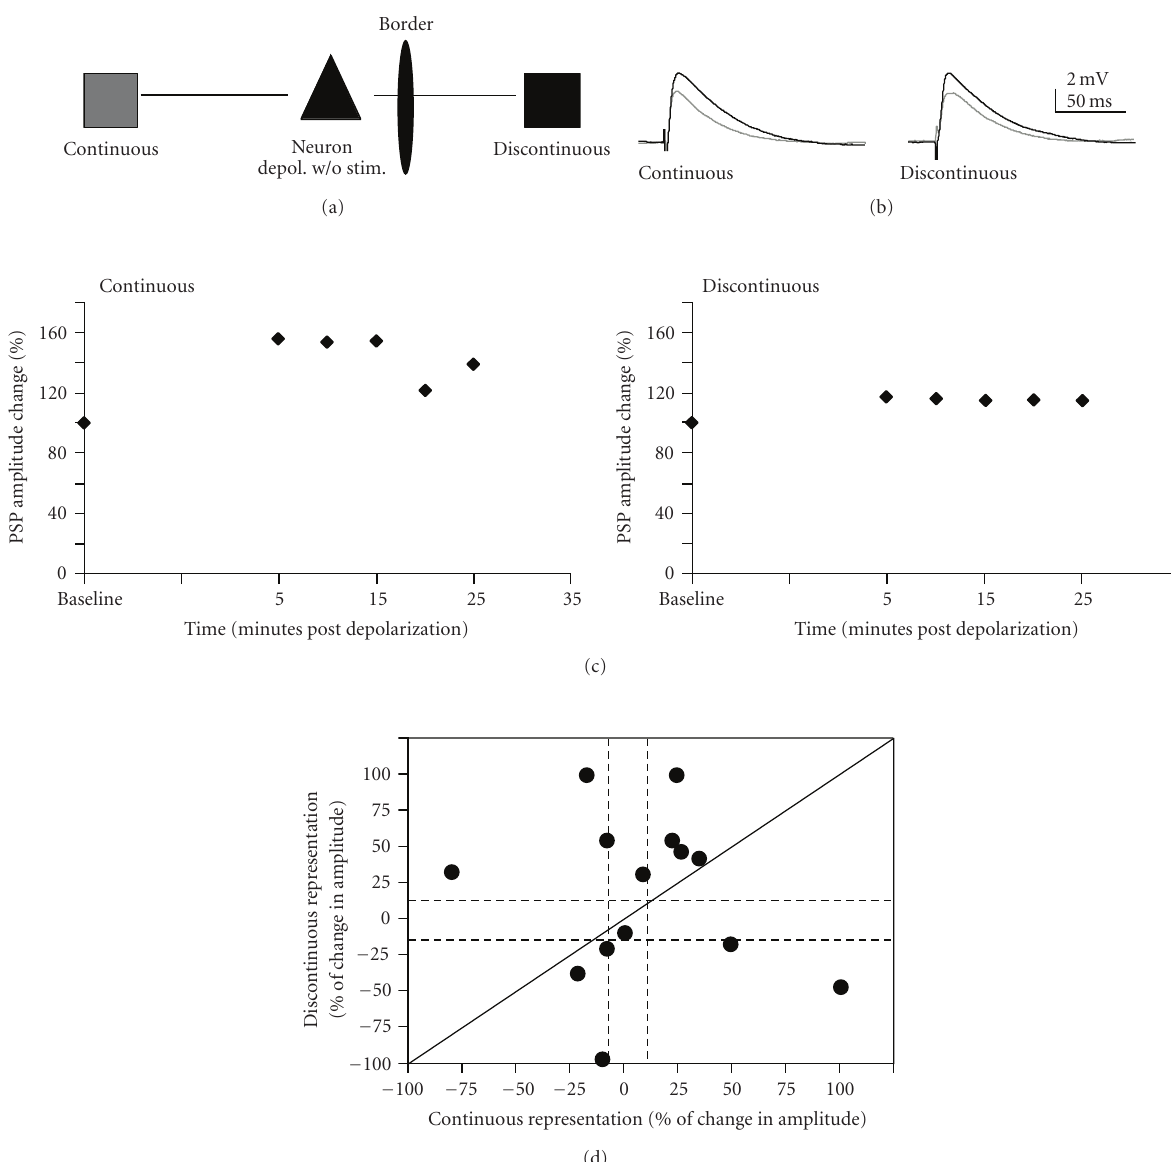
Figure 6: LTP of neurons that received depolarization without synaptic stimulation. (a) Schematic of connections. No pairing was given, only robust depolarization. (b) Example of PSPs. Gray traces are averaged baseline PSPs. Black traces are averaged traces 20 minutes postpairing. Traces are averaged over 5 minutes (15 traces) for both pre- and postpairing PSPs. (c) % change of PSP amplitude over time for the cell shown in 2. PSP amplitude change was averaged over five minute intervals. (d). Individual data: change in PSP amplitude (expressed as percent of the baseline PSP amplitude) for continuous representation plotted against discontinuous representation pathway for each cell that received depolarization only. Conventions are as in Figure